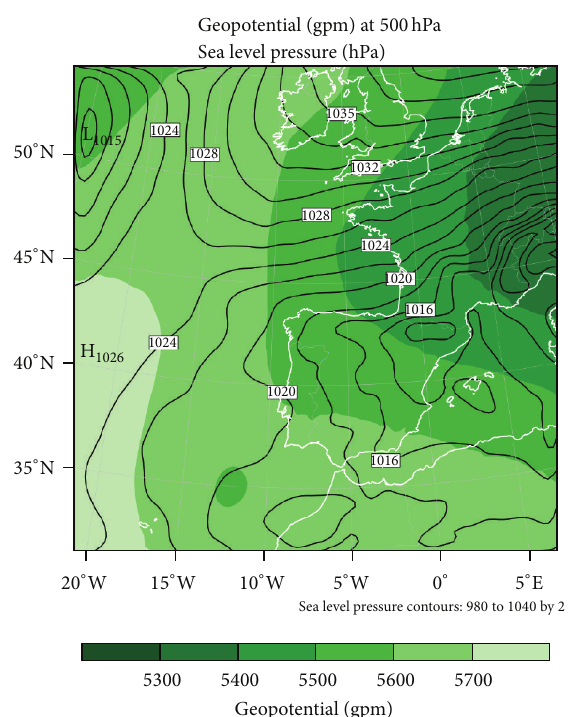
Figure 8: Sea level pressure and geopotential height at 500hPa modeled by WRF for domain D01.